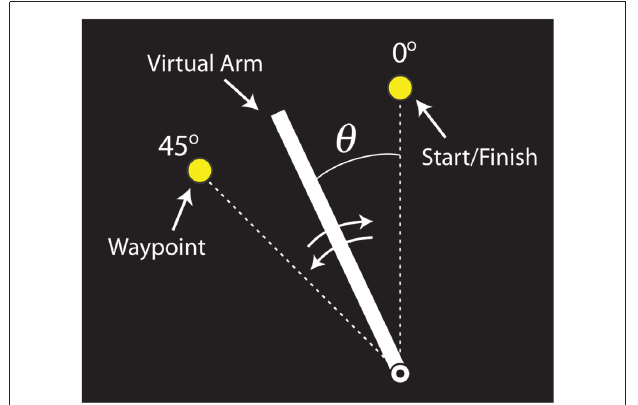
FIGURE 4 | Visual feedback of the virtual arm provided to participants (labels included for clarity). The virtual arm started in the vertical position (0 ◦ ). The task was to move the virtual arm to the waypoint (45 ◦ ) and then back to the starting position, i.e., perform a back-and-forth slicing